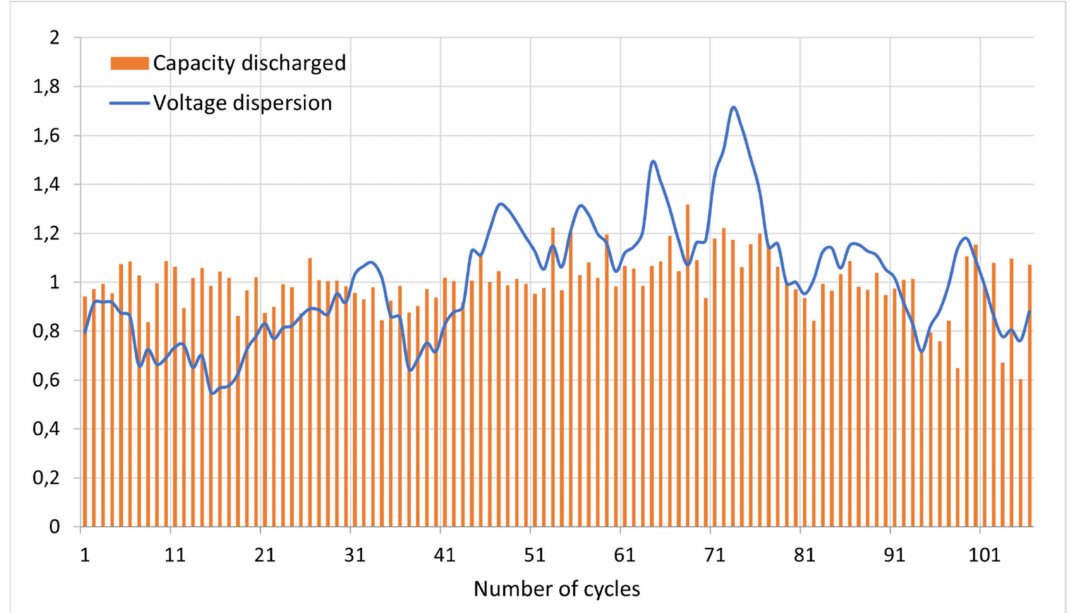
Figure 13. Voltage dispersion (w.c.) vs. capacity discharged for battery